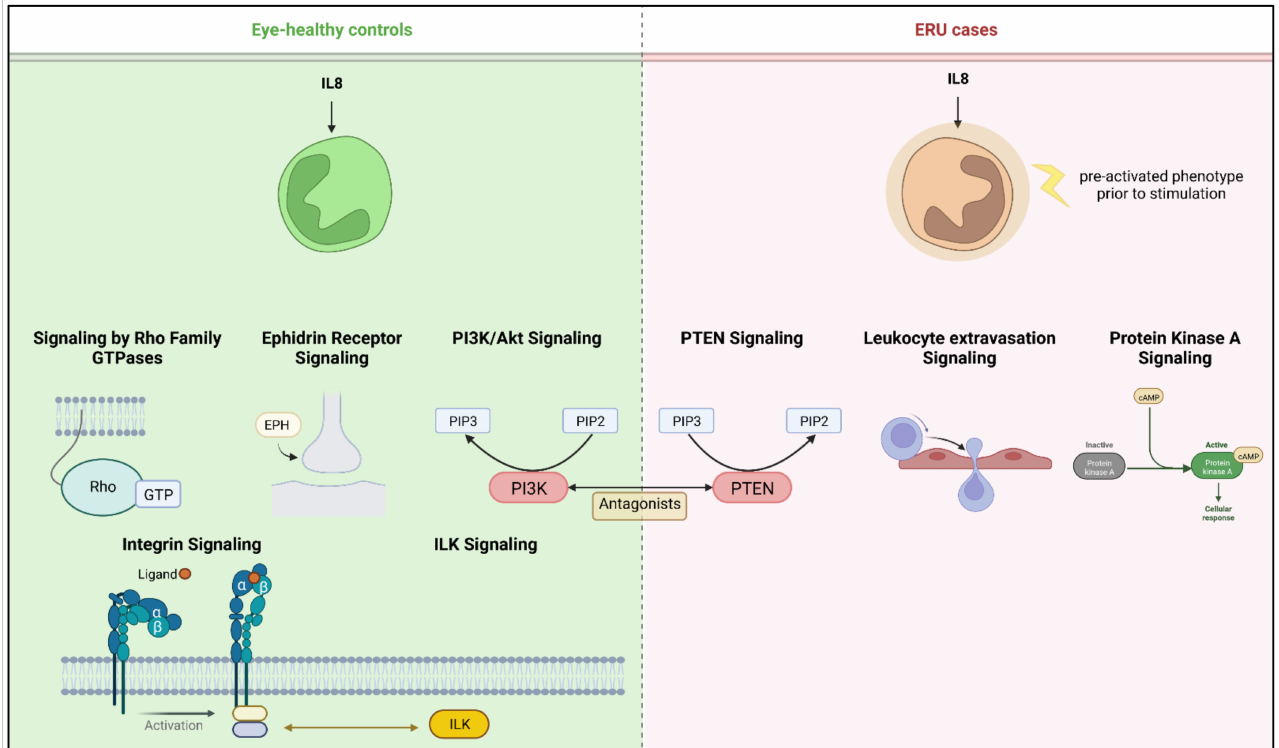
Figure 3. Overview of pathways with predicted activation after IL8 stimulation of equine granulo- cytes. Left panel shows canonical pathways activated in granulocytes from healthy horses; for better clarity, pathways from the same functional category were merged. Right panel shows respective activation in intrinsically pre-activated ERU granulocytes. Created with